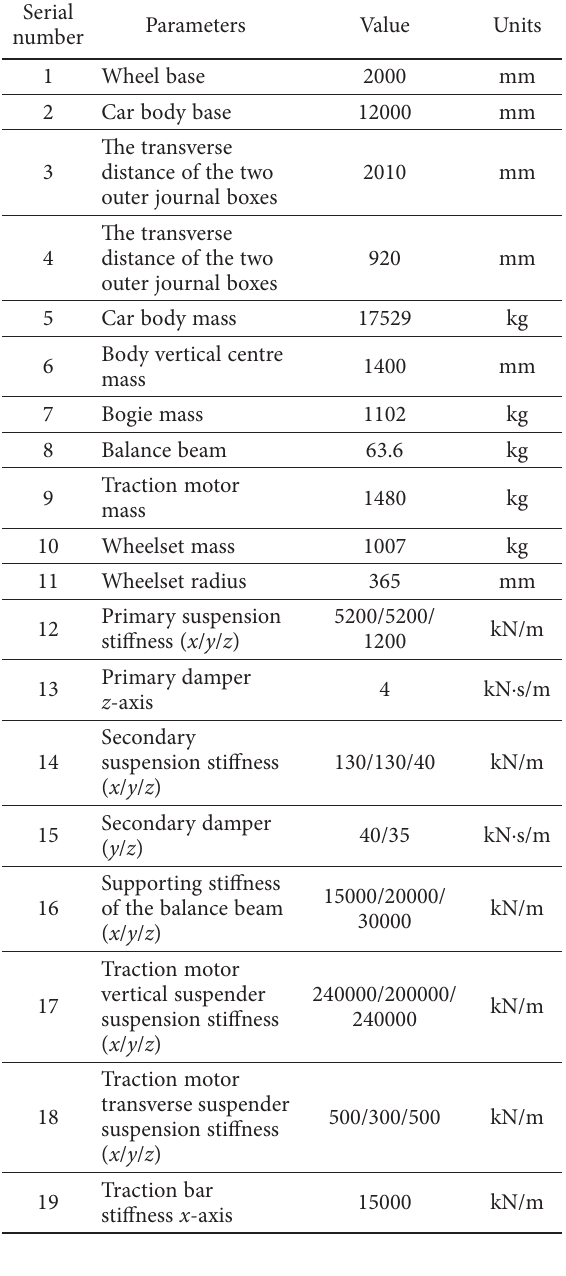
Table. Main suspension parameters of the vehicle